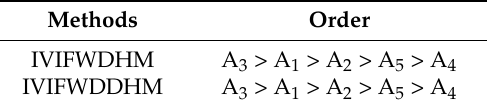
Table 4. The order of the tourism scenic spots.